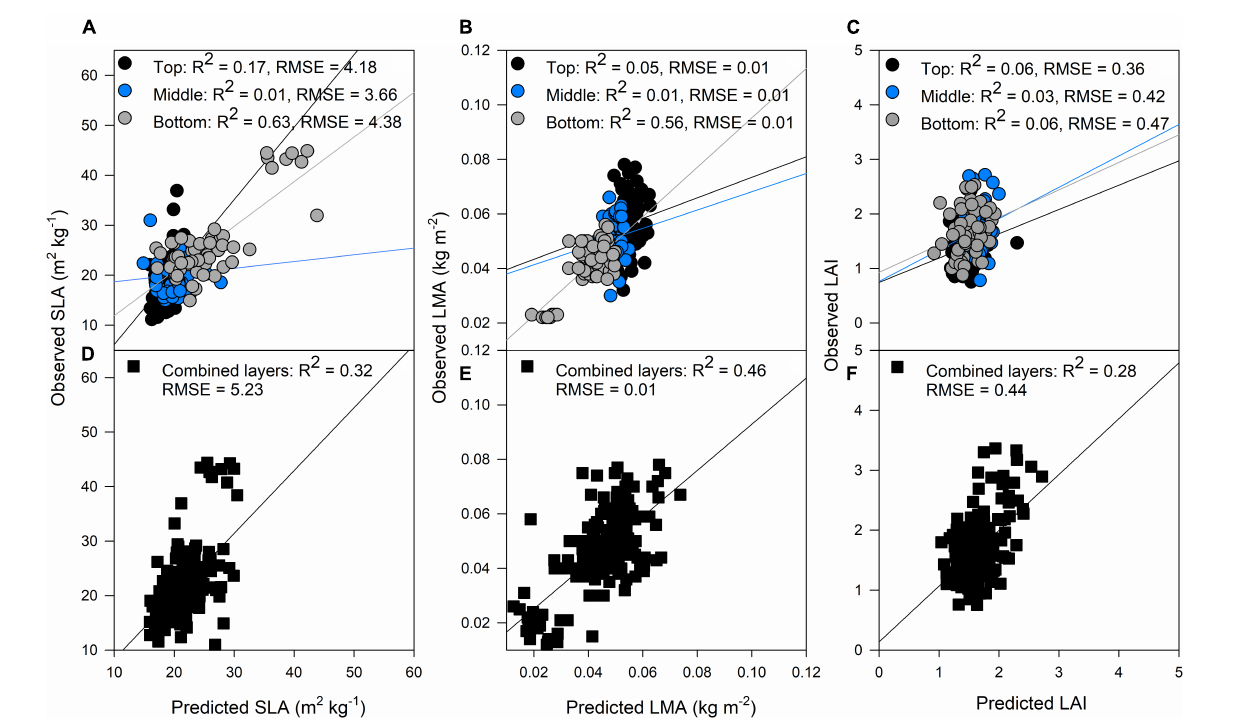
FIGURE 3 | Validation results of PLSR models predicting specific leaf area (SLA) (A) , LMA (B) , and LAI (C) by separating each layer of the canopy (top panels) and predictions of SLA (D) , LMA (E) , and LAI (F) combining all the layers of the canopy (black squares). Black dots: top of the canopy, blue dots: middle of the canopy, gray dots: bottom of the canopy. The lines represent the linear regression between predictions and ground truth